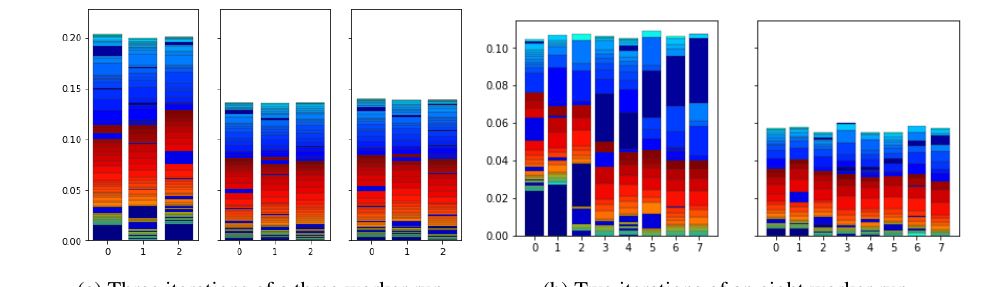
Figure 2: Load balancing of our task queue algorithm. Each panel represents one gradient calculation. Each gradient calculation consists of 265 partial derivatives, each of which is shown as a di ff erently colored stacked “sub”-bar. The three or eight main bars each represent work done on one of the workers used in that run. Vertical axis shows wall clock time in seconds.